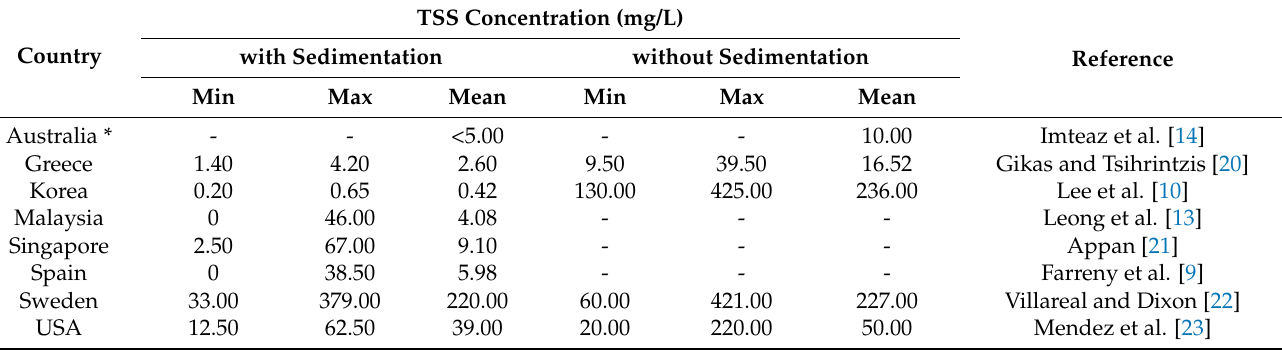
Table 1. Measurements on TSS concentration.